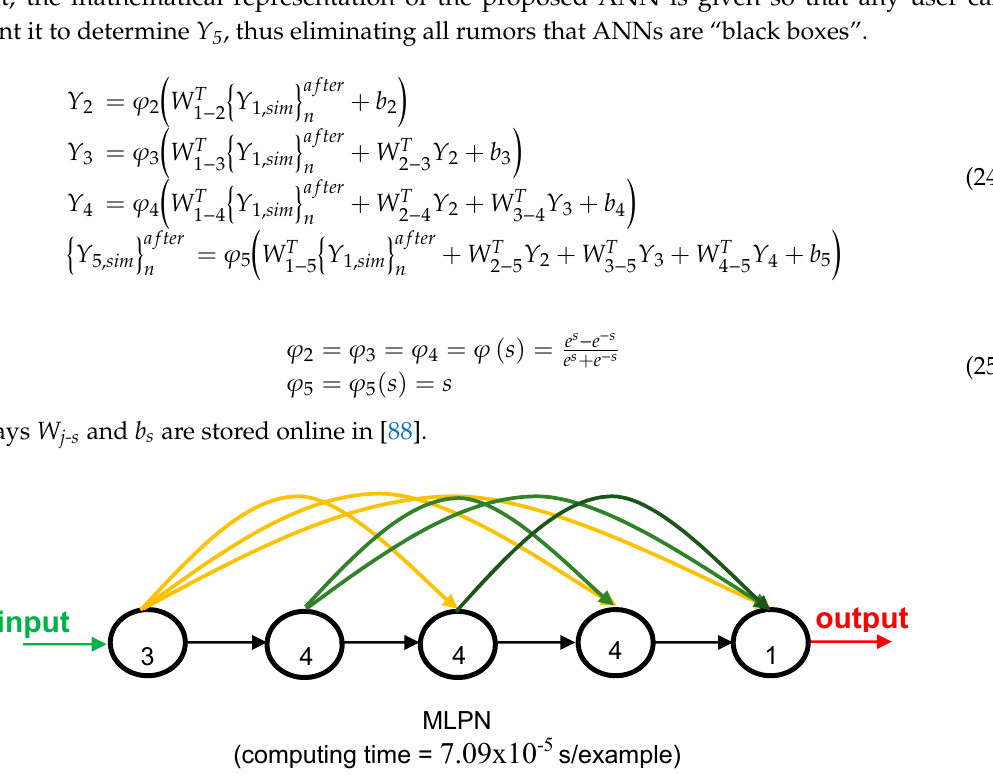
Figure 4. Proposed 3-4-4-4-1 fully connected MLPN—simplified scheme.